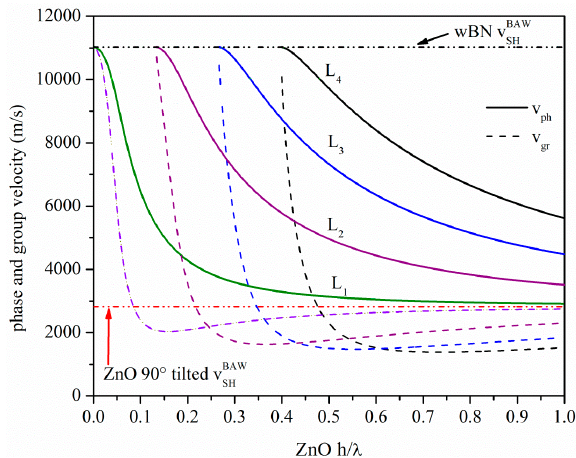
Figure 6. The phase and group velocity dispersion curves of the Love modes travelling along the x propagation direction of c-axis inclined ZnO/wz-BN.